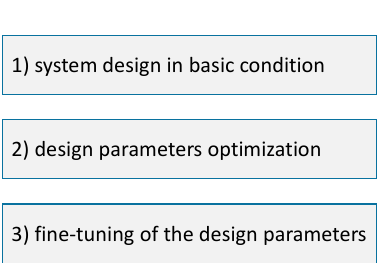
Figure 3. Robust optimization procedure.